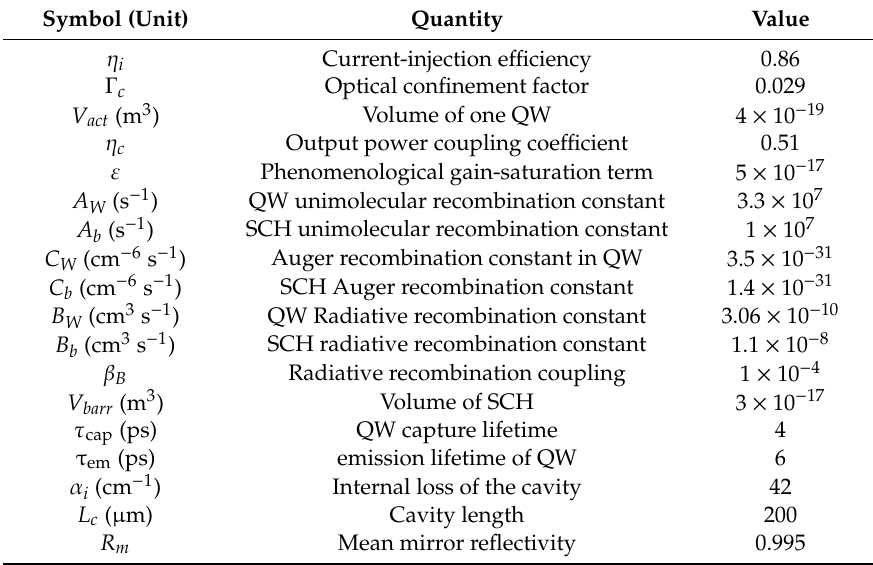
Table 2. Relevant parameters used for evaluating P-I characteristics.